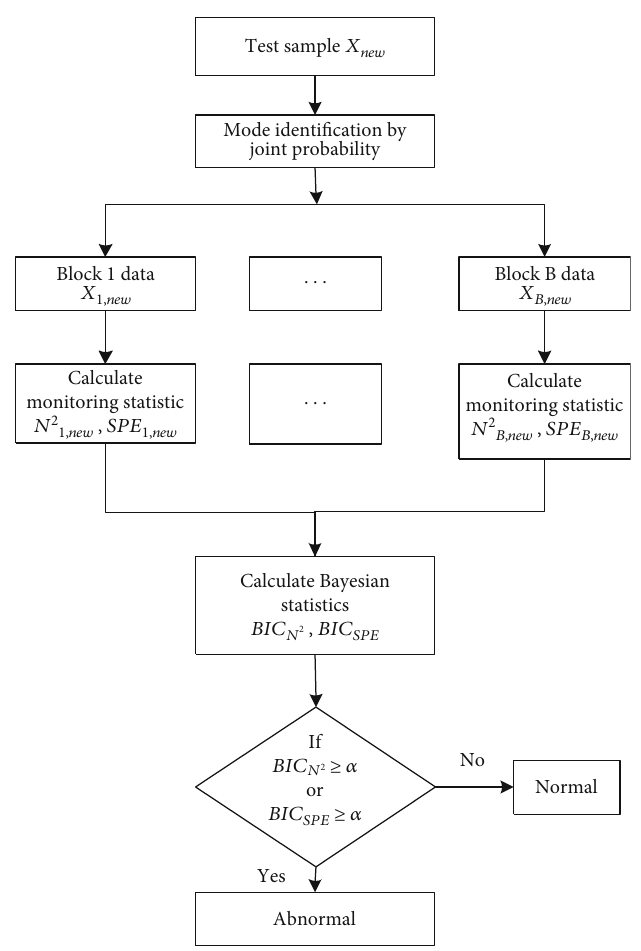
Figure 2: Online monitoring fl